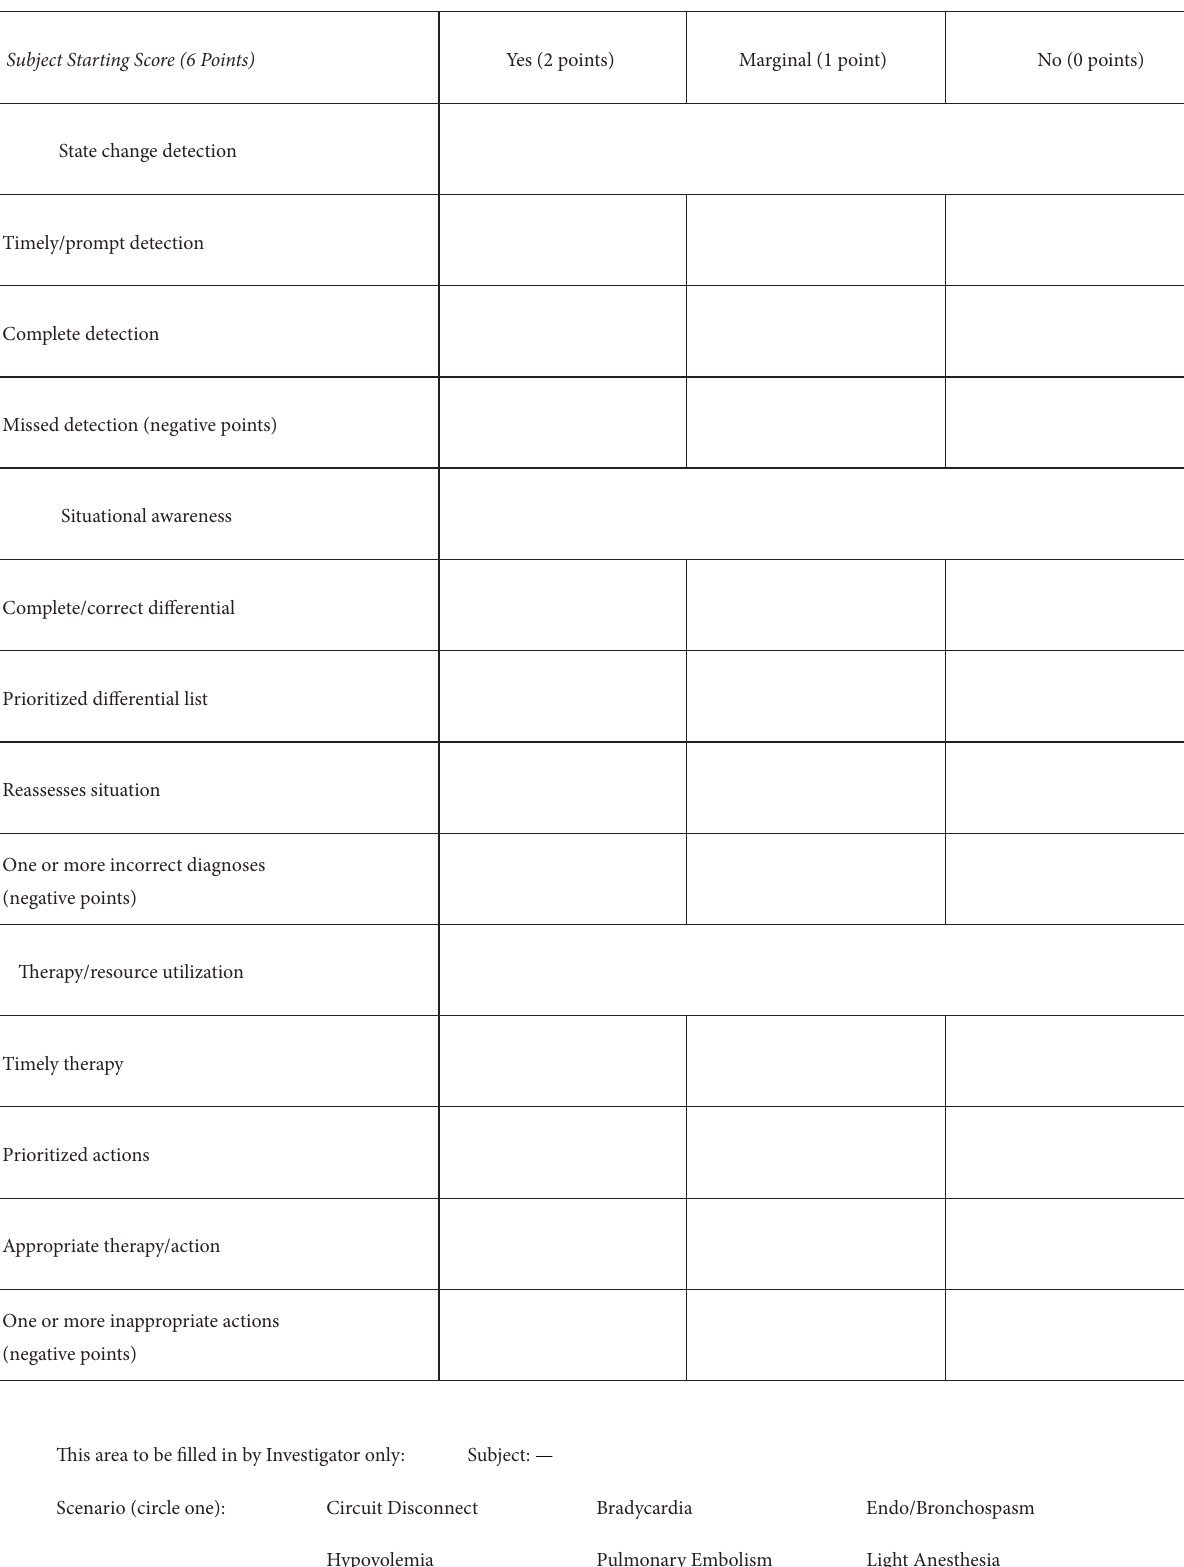
Figure 8: The Crisis Management Checklist used by expert raters to assess performance of subjects in